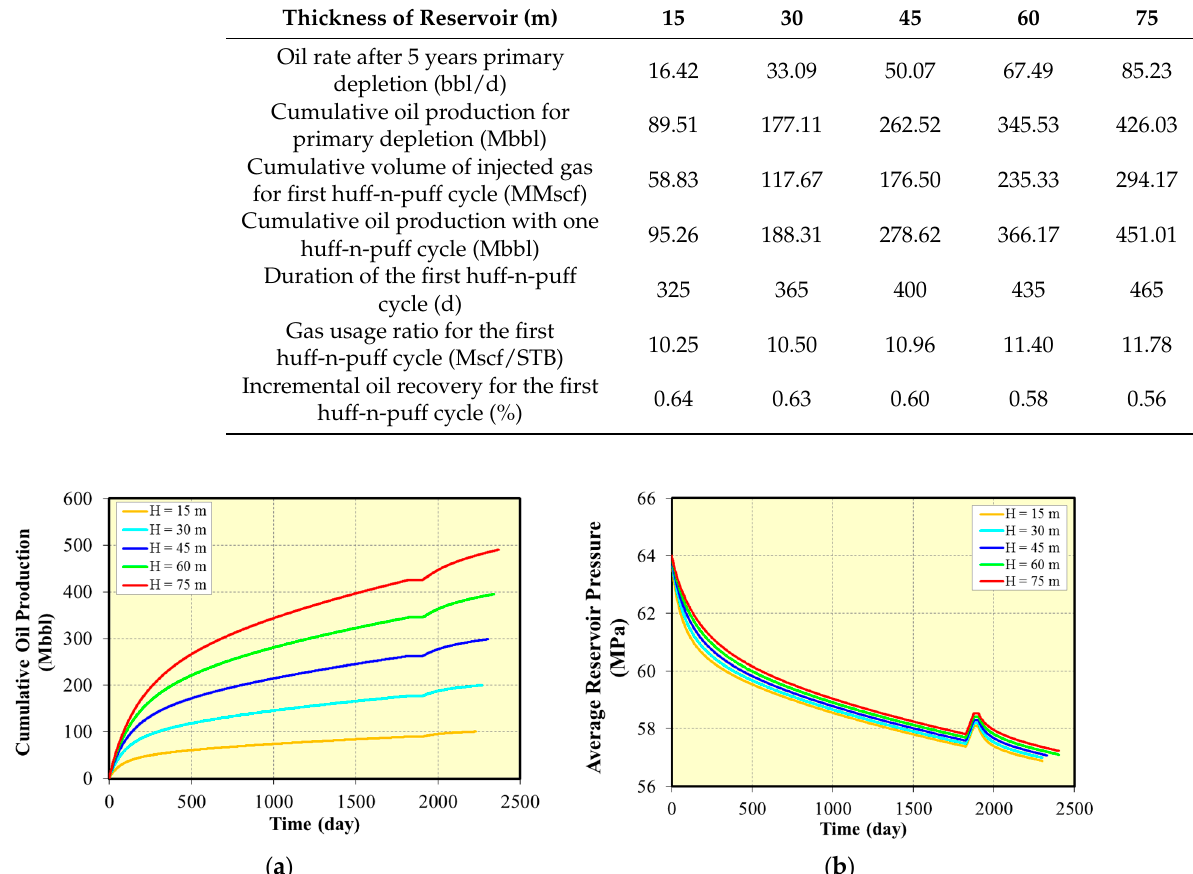
Table 7. Summary of results for huff-n-puff with different reservoir thickness.